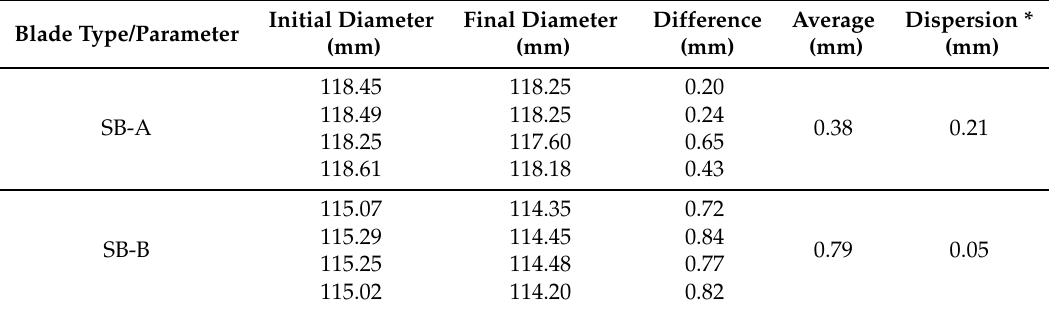
Table 3. Tool wear analyses by measuring the diameter